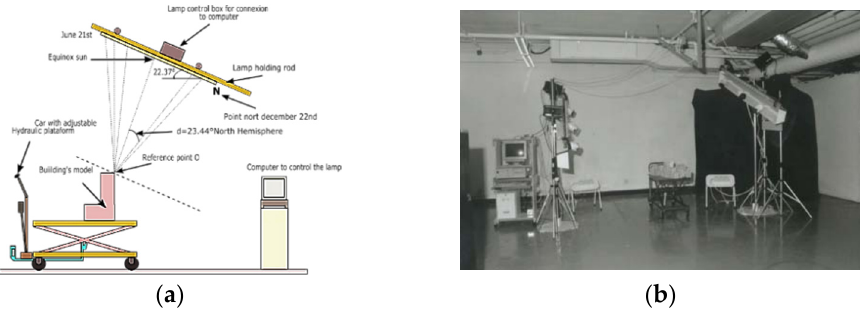
Figure 1. Multi-lamp heliodon for architectural schools: ( a ) schematic diagram and ( b ) photograph.